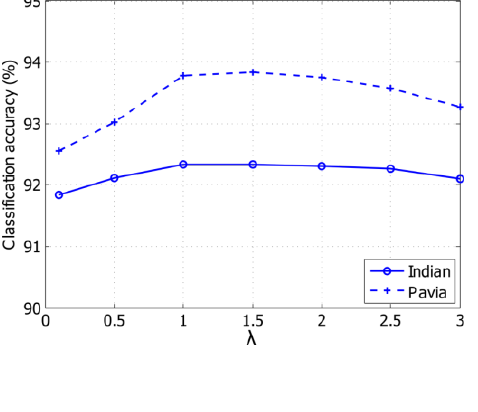
Figure 6. Classification accuracy (%) for Indian Pines and University of Pavia datasets as a function of the MH-prediction regularization parameter λ for the proposed MH-KELM using 20 labeled samples per class. The search-window size for MH prediction is d = 9 ×